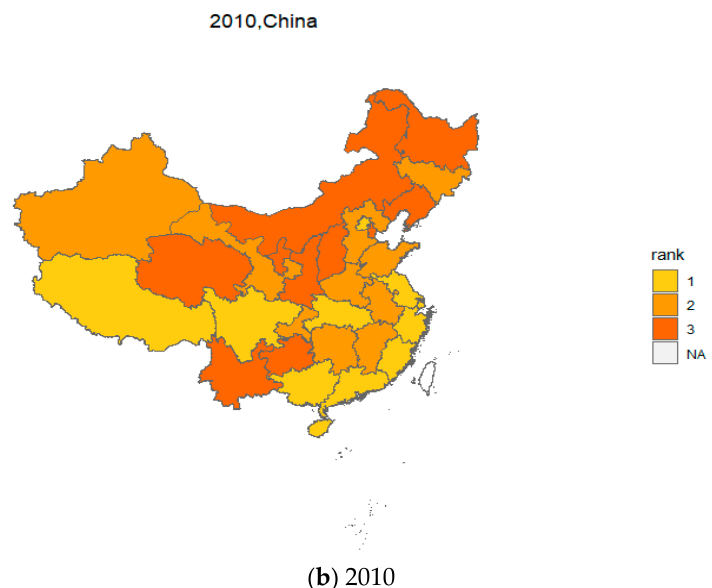
Figure 2. Distribution of the proportion of employment in the energy resource exploitation industry to total number of employed people in ( a ) 2000 and ( b ) 2010, in China.